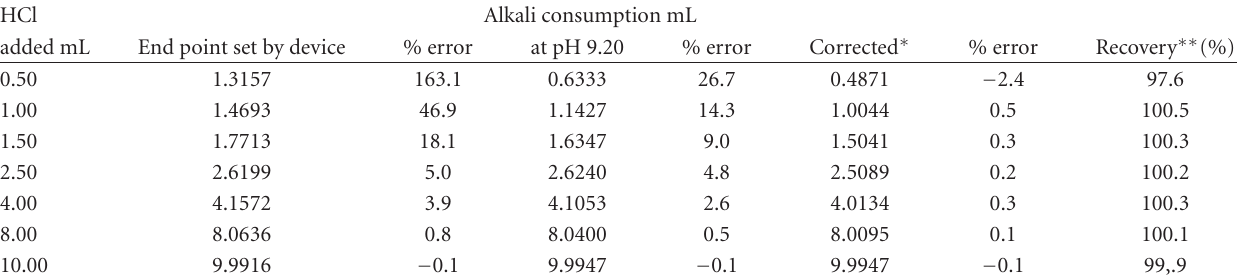
Table 1: The e ff ect of dilution on the titration of a strong acid in aqueous Na 2 HPO 4 solution. HCl Alkali consumption mL added mL End point set by device % error at pH 9.20 % error Corrected